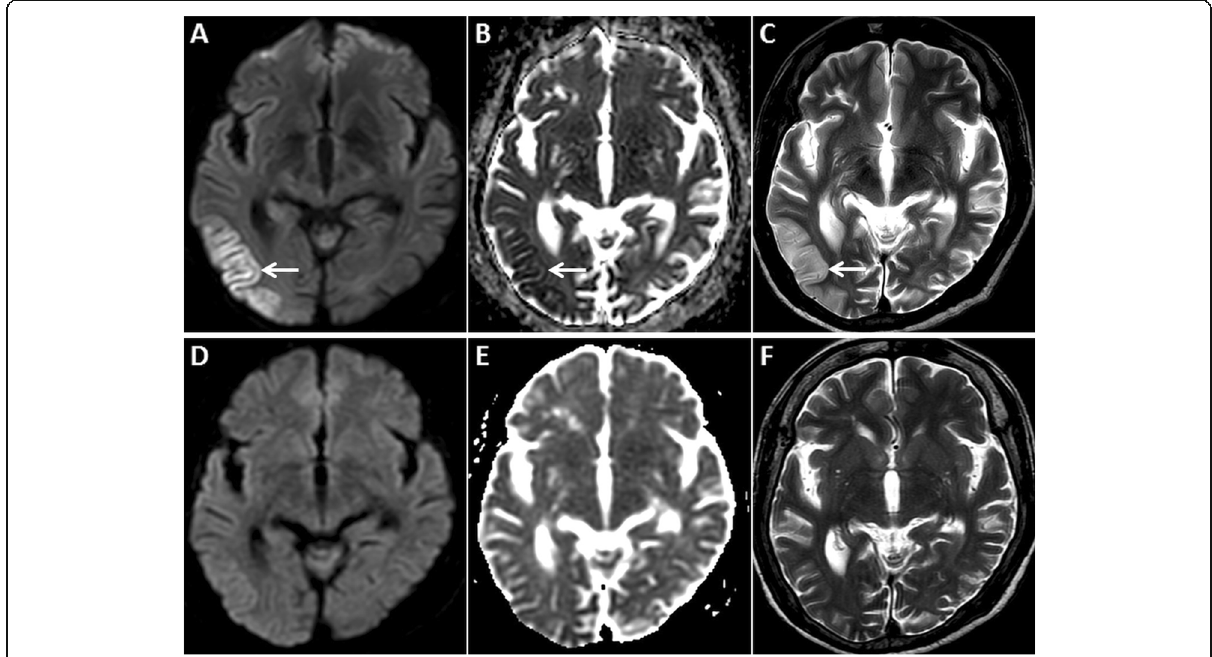
Fig. 3 MRI of the brain in a 67-year-old female patient presenting with a seizure. GRD is observed in the right temporo-occipital region (arrow) on axial DWI ( a ) and ADC image ( b ). Also note associated cortical swelling and hyperintensity (arrow) on axial T2W image ( c ). Follow-up MRI after 4 days reveals complete resolution of the cortical signal abnormality and swelling on axial DWI, ADC and axial T2W images ( d , e , f , respectively)